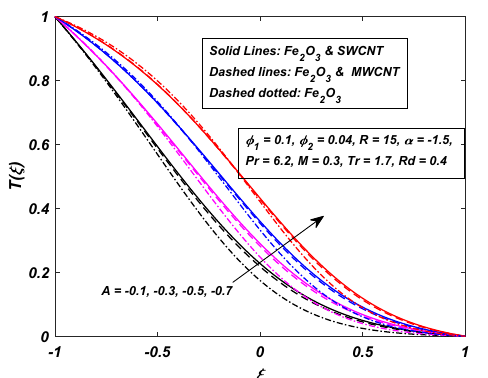
Figure 11. Influence of − A on T ( ξ ).